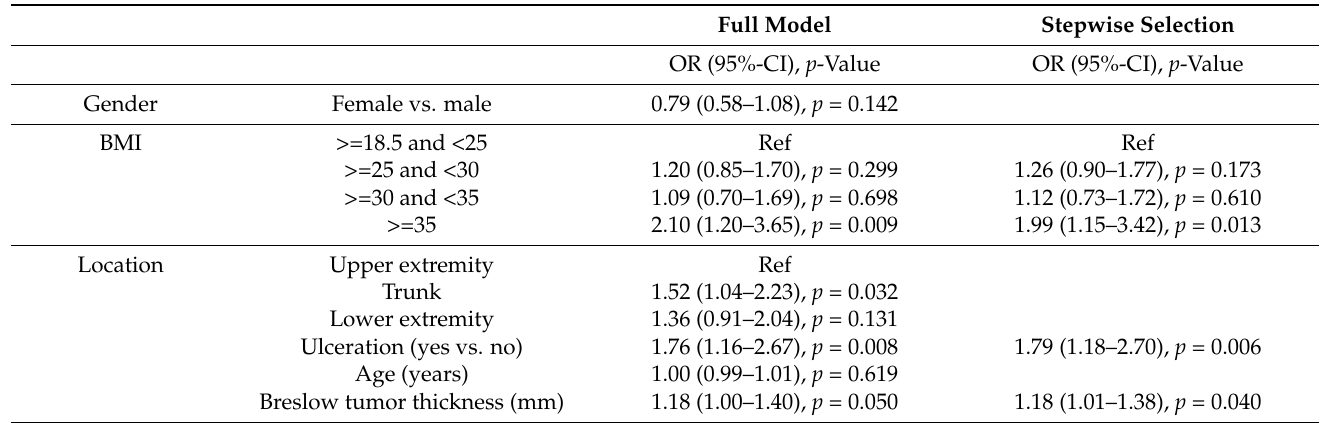
Table 7. Metastases in the sentinel lymph node biopsy—multivariate analysis (logistic regression) (n =